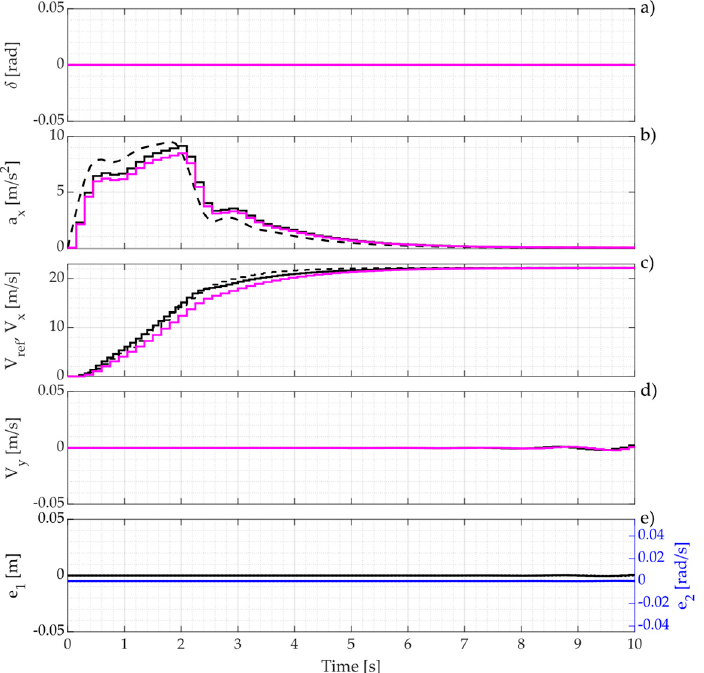
Figure 14. Results obtained during the straight road portion in PIL configuration (see Figure 8). Measured vehicle states for Speedgoat (black) and for Raspberry Pi 4B (magenta): ( a ) Front wheels steering angle δ ; ( b ) Longitudinal acceleration a x ; ( c ) Longitudinal speed reference V ref (black, dashed) vs. Actual longitudinal speed V x ; ( d ) Lateral speed V y ; ( e ) Cross track e 1 for Speedgoat (black, solid) and Raspberry Pi 4B (black, dotted) and Relative yaw angle e 2 for Speedgoat (blue, solid) and Raspberry Pi 4B (blue, dotted).